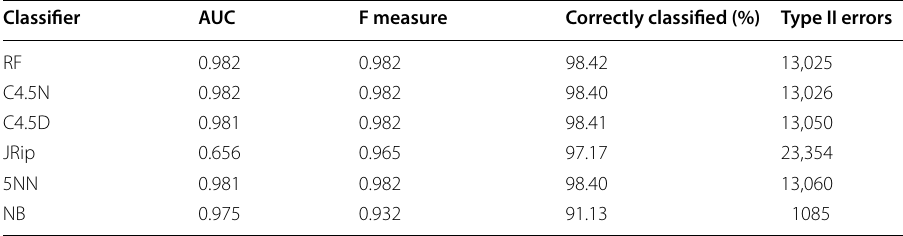
Table 10 Classifier subset evaluator results